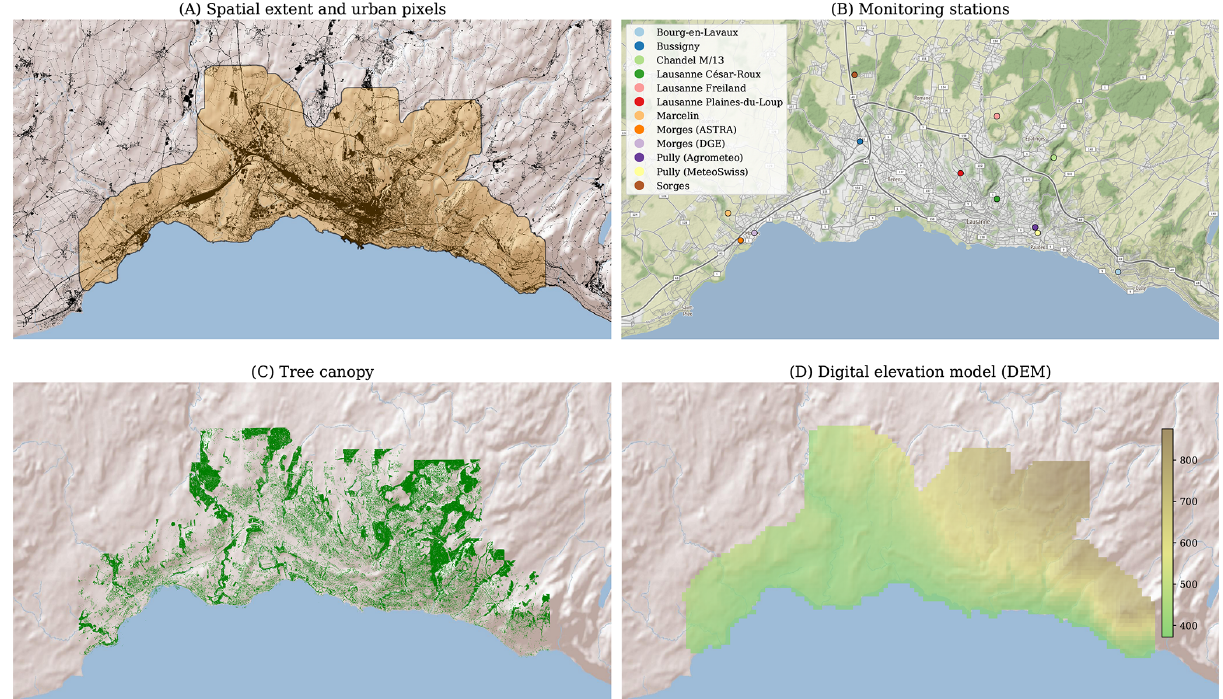
Figure 1. Study area. The upper left plot (A) shows the computed spatial extent (in orange) over the repartition of urban pixels (in black) derived from the rasterized cadastral survey (Association pour le Système d’information du Territoire Vaudois, 2018). The upper right plot (B) shows the locations of the air temperature measurement stations (see Appendix A2). The bottom row shows, for the computed spatial extent of the study, (C) the tree canopy map derived from the SWISSIMAGE orthomosaic (Federal Office of Topography, 2019) and (D) the altitude map derived from the free version of the digital height model of Switzerland (Federal Office of Topography, 2004). The basemap of plots (A) , (C) and (D) is based on the World Shaded Relief (© 2009 Esri). The basemap tiles of plot (B) have been provided by Stamen Design (https://stamen.com, last access: 28 July 2020), under a Creative Commons BY 3.0 License (http://creativecommons.org/licenses/ by/3.0, last access: 28 July 2020), with data from OpenStreetMap (https://openstreetmap.org, last access: 28 July 2020, © OpenStreetMap contributors 2021, distributed under a Creative Commons BY-SA